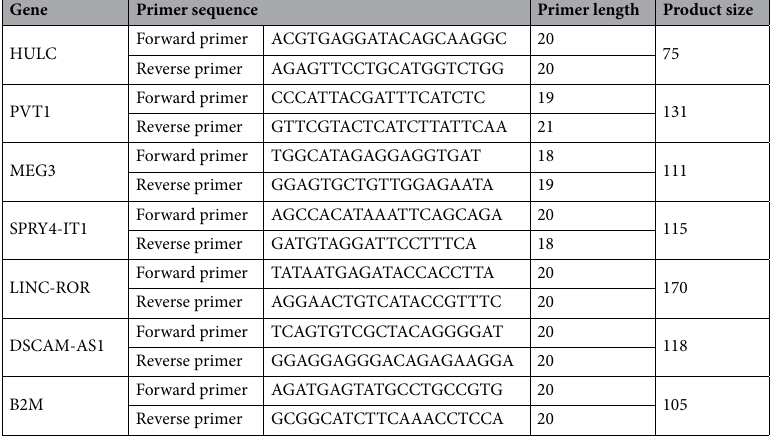
Table 1. Characteristics of primers designed for amplification of HULC , PVT1 , MEG3 , SPRY4-IT1 , LINC-ROR and DSCAM-AS1